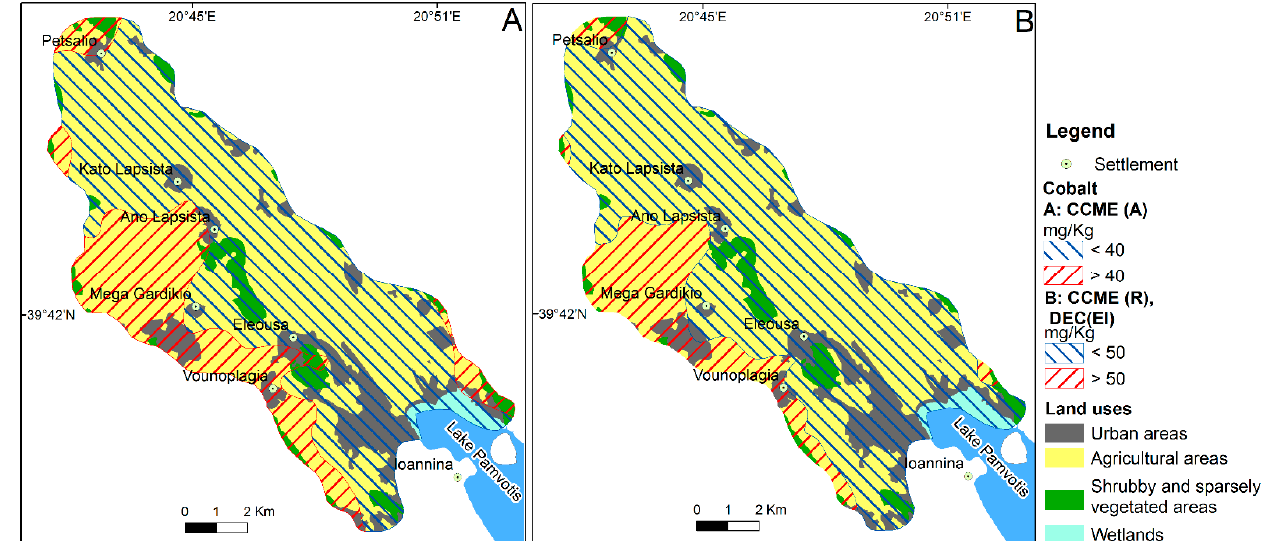
Figure 9. Suitability map comparing Co content in soil of the study area to: ( A ) CCME (A); and ( B ) CCME (R).